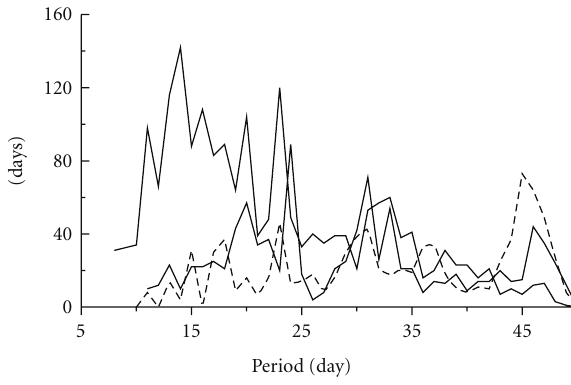
Figure 5: The occurrence of the wave oscillation with various periods in the temperature and Δ foF2 during 2006-2007: thick line— Δ foF2; thin line—the stratospheric temperature, dotted line—the mesospheric